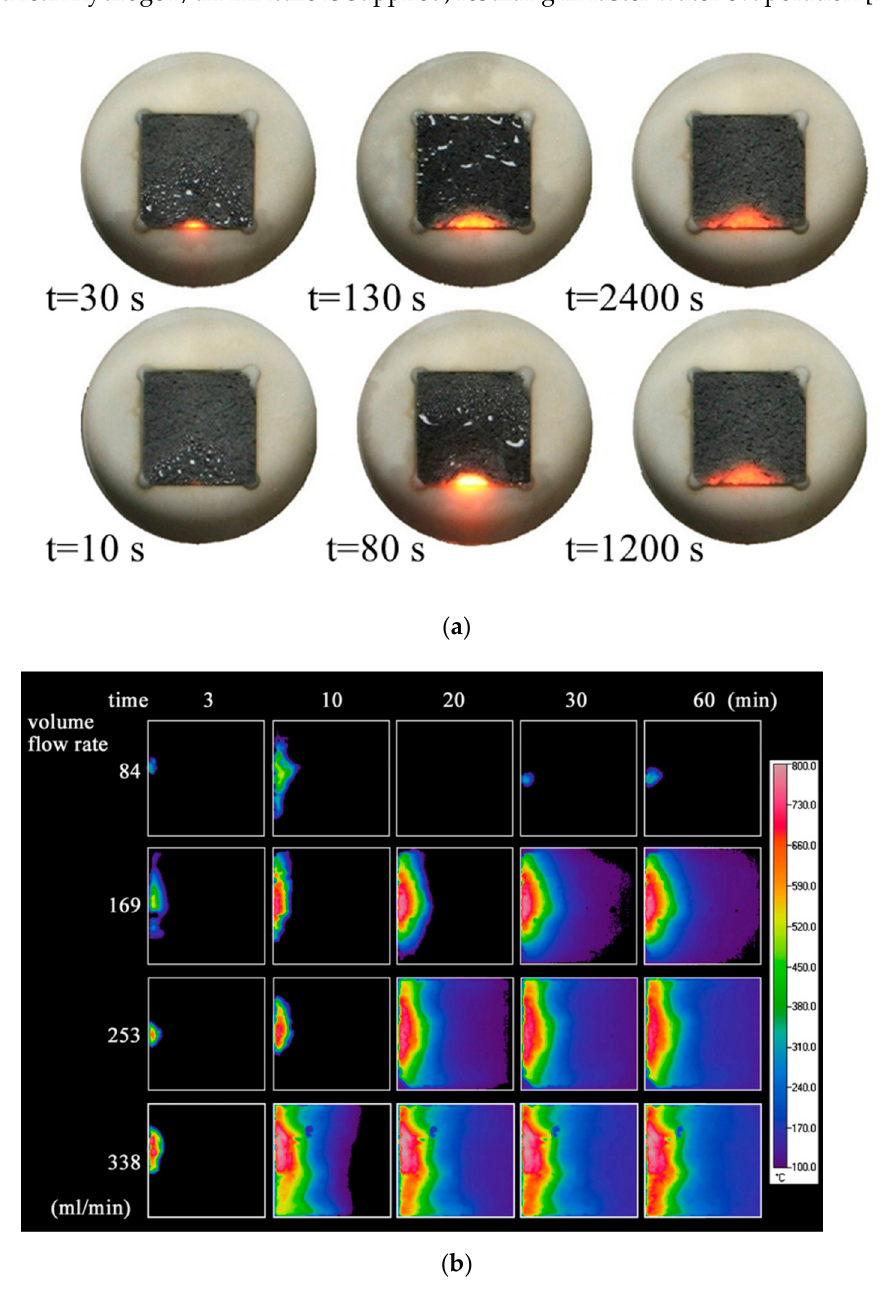
Figure 8. ( a ) Surface images of the Pt/Isolite B5 combustor chamber at various periods of the CHC reaction (adapted from [168] with permission from Elsevier); ( b ) thermal imaging of the chamber interior at different hydrogen flow rates and periods (reproduced from [168] with permission from Elsevier).